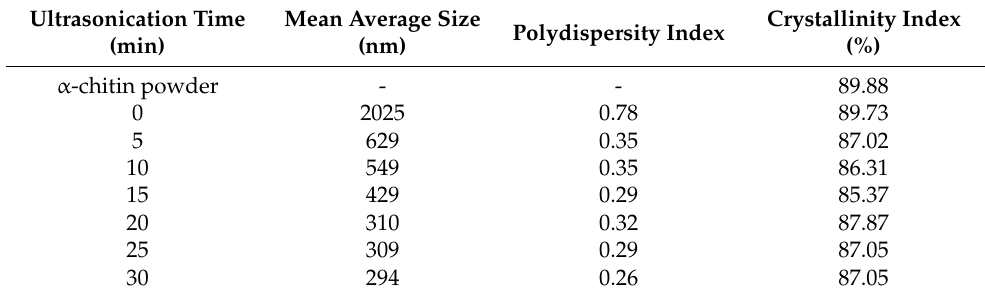
Figure 5. The effect of ultrasonication time on partially deacetylated chitin nanofiber size distribution. Table 1. Mean average size, polydispersity index, and crystallinity index of partially deacetylated α -chitin